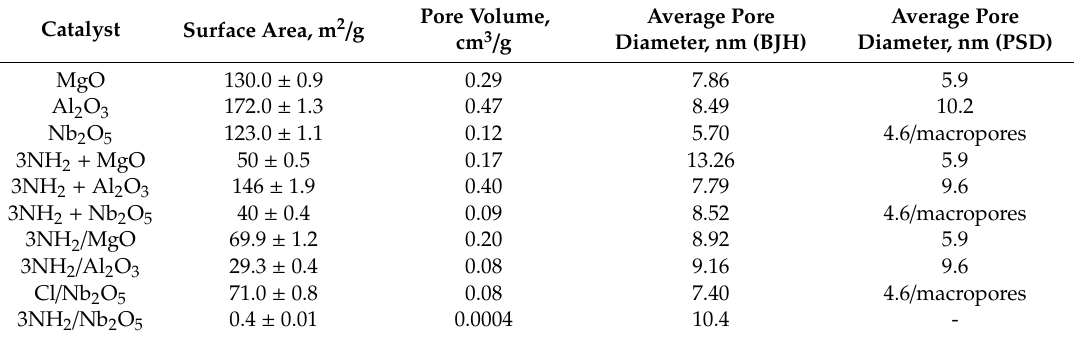
Table 3. The texture / structure parameters of the modified metal